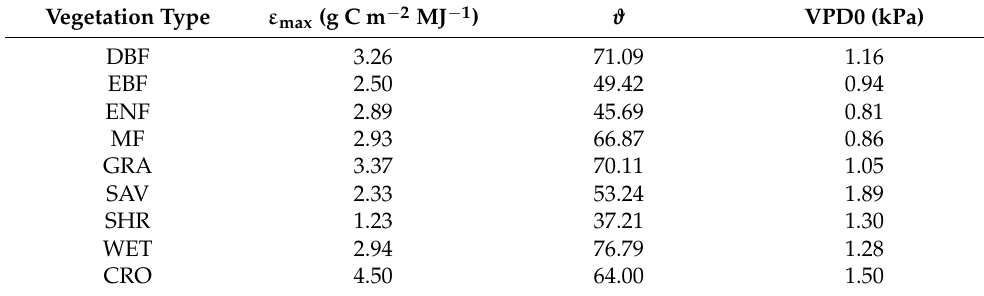
Table 3. Model coefficients of the fine-spatial-resolution GPP from the GEE APP. Model coefficients are linked to Equations (1), (4) and